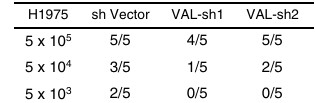
cells (Supplementary Fig. 3j). On the contrary, silencing VAL drastically abrogated the abilities of H1975 cells to form systemic metastases (Fig. 2h – j and Supplementary Fig. 3i, j). Furthermore, in the orthotopic implantation model, while the growth of orthotopic xenografts of vector-control A549 or H2009 cells in the lung tissue was exclusively restricted in few lesion sites, VAL-